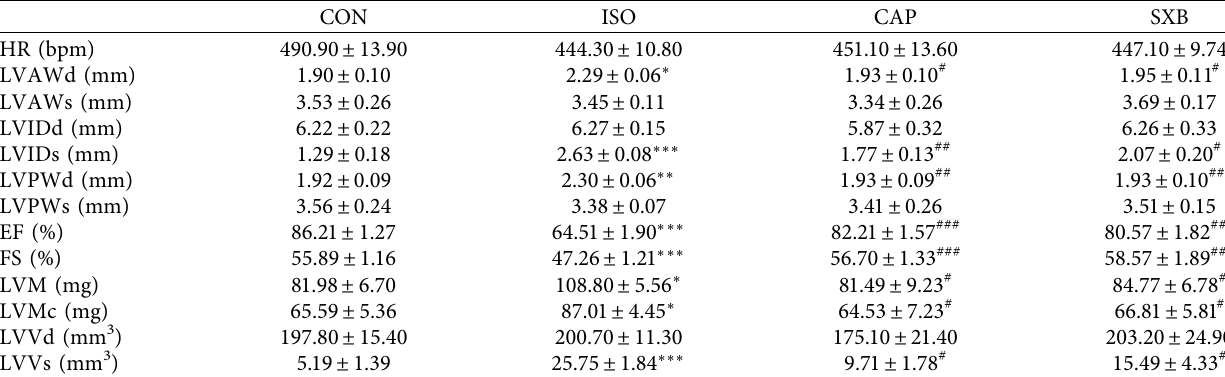
Table 1: Echo values among the 4 groups (CON, ISO, CAP, and